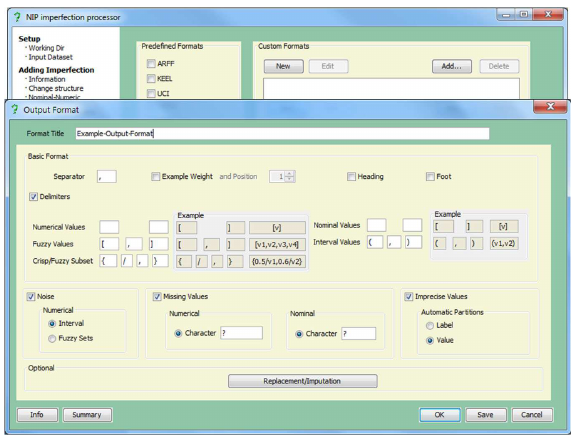
Fig. 7. Output format